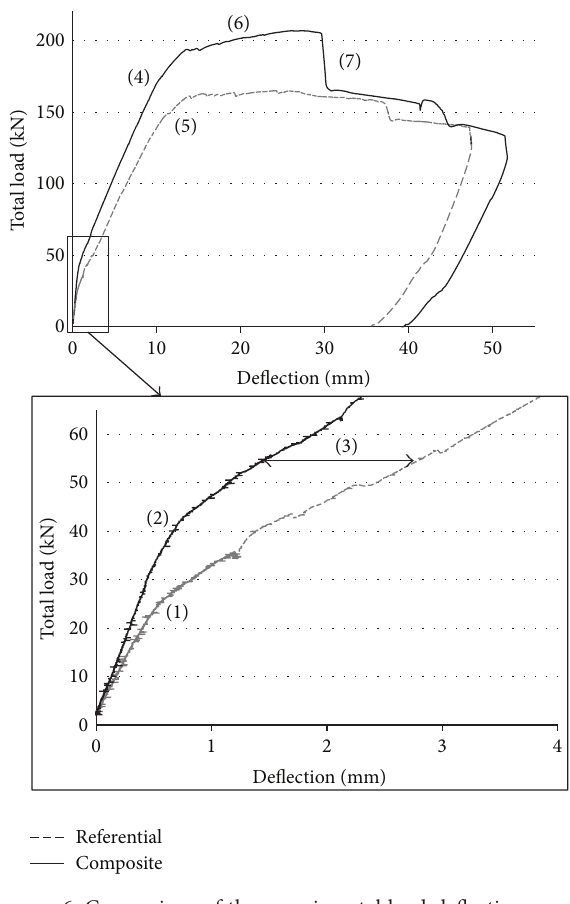
Figure 6: Comparison of the experimental load-deflection curves of fully steel reinforced beam and composite beam.